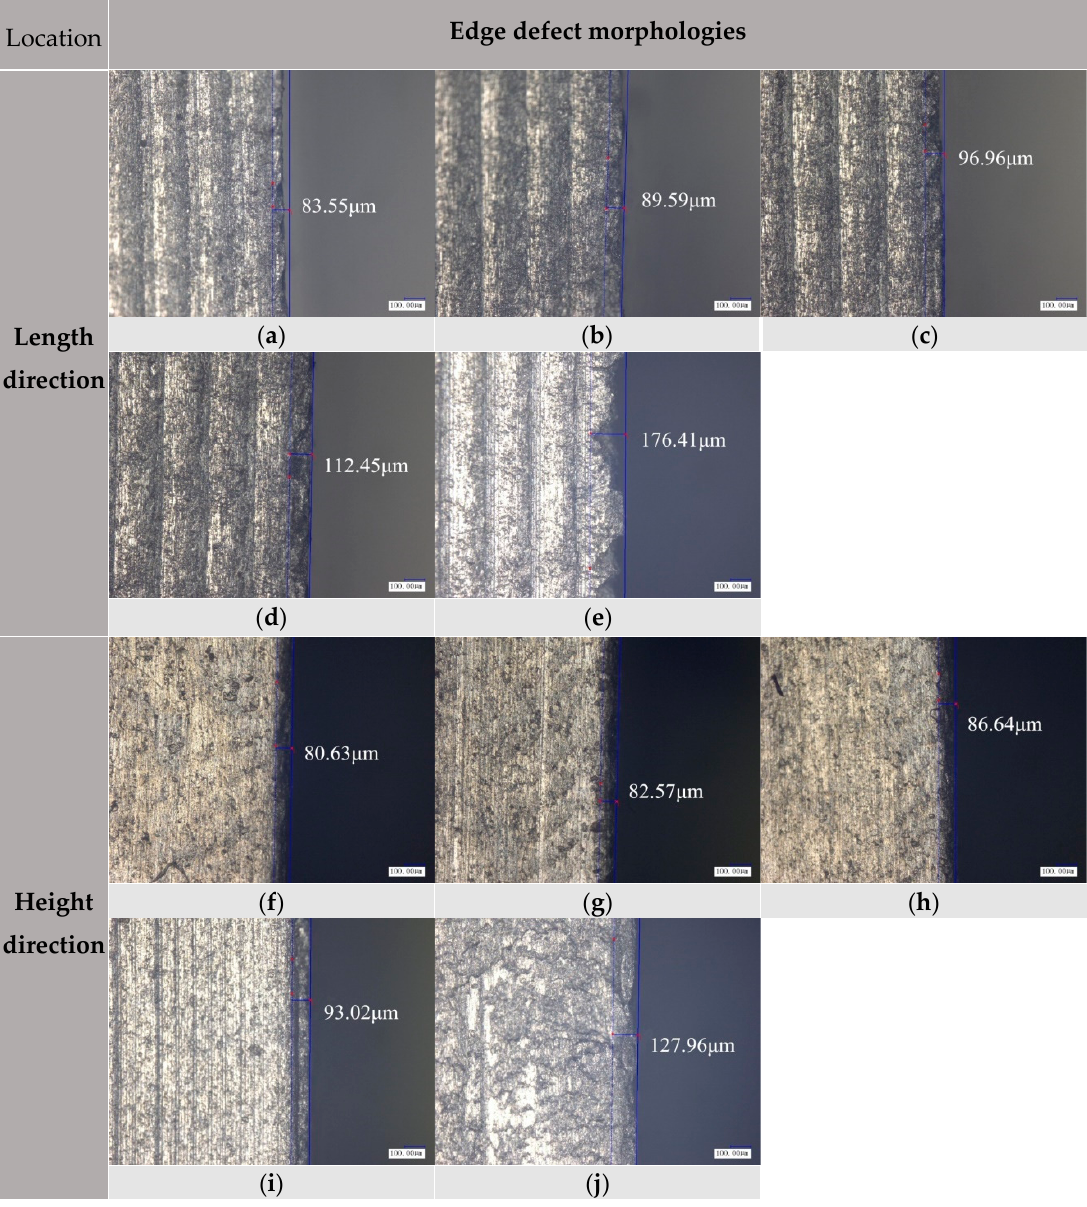
Figure 4. Process of edge defect formation.